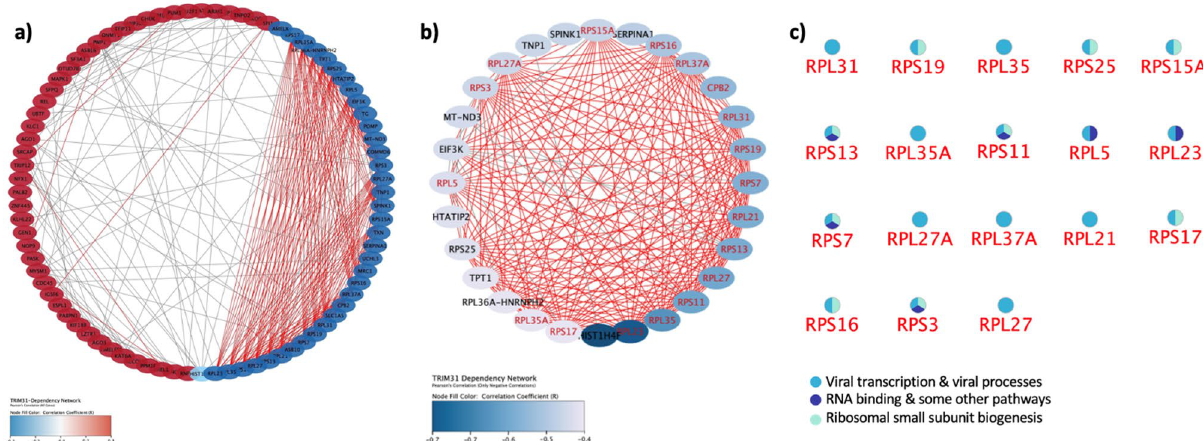
Figure 6. PPI network analysis for affected genes when TRIM31 was silenced in 20 CRC cell lines using rnai. while upregulated genes with red circles exhibited weak co-expression score (less than 0.5), blue circles indicating downregulated genes showed co-expression score bigger than 0.5 ( a ). Blue circles exhibiting downregulated genes are highlighted with red coloured text exhibited 18 nodes indicating similar processes using gene ontology analysis ( b ). The 18 nodes indicating cellular processes that mostly affected by TRIM31 silencing are presented by the names of these proteins and their cellular function such as viral transcription & viral processes, RNA binding, and ribosome small subunit biogenesis are listed ( c ). Majority of these cellular processes that are affected by TRIM31 silencing in crc cell lines are related to viral transcription & viral